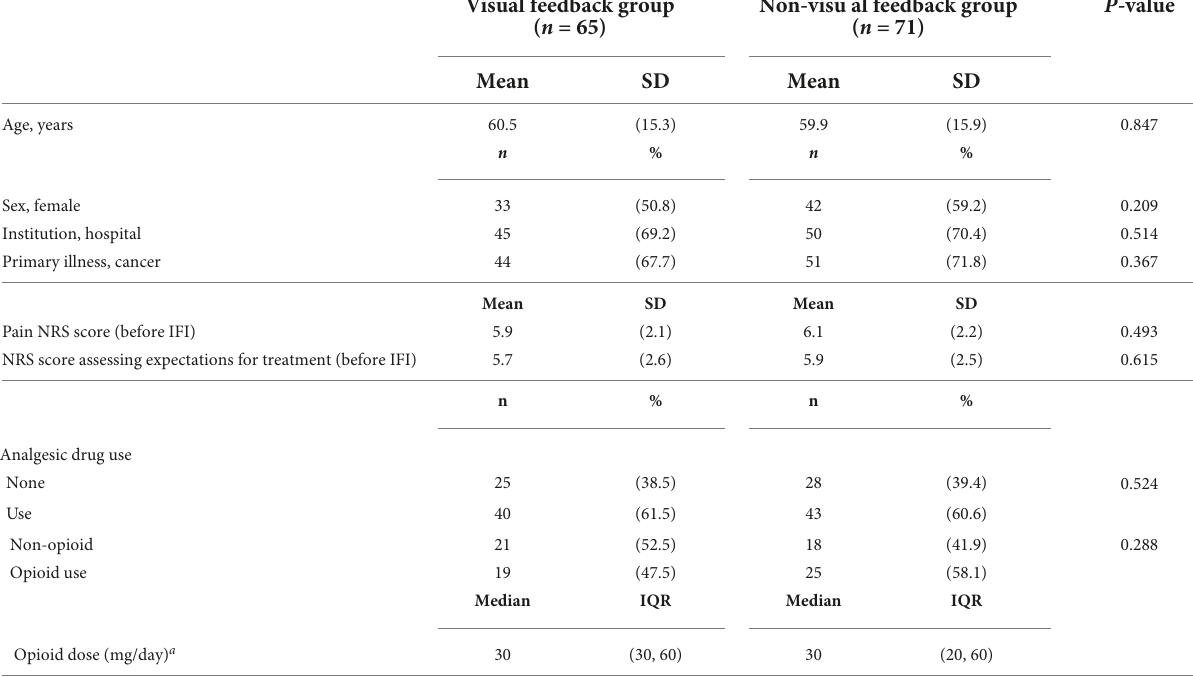
TABLE 1 Clinical characteristics of the visual feedback and the non-visual feedback groups.